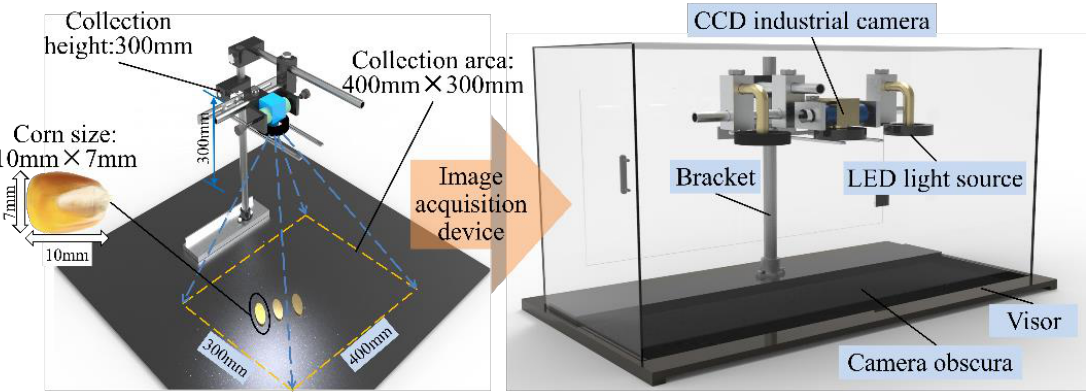
Figure 2. Pictorial representation of the hardware of the machine vision system. CCD: charge-coupled device.